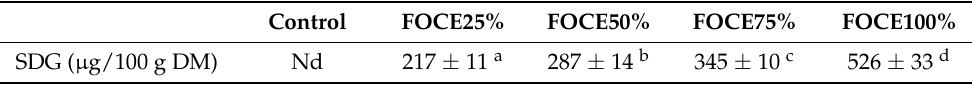
Table 2. Amount of SDG in the experimental GFBs with FOCE.